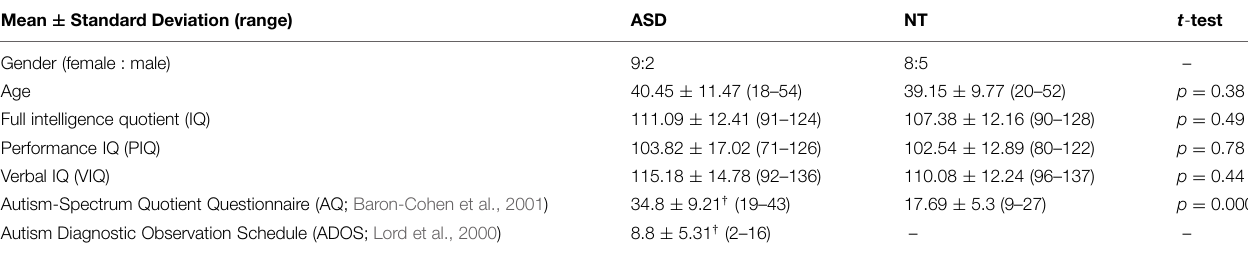
TABLE 1 | Mean-group matching data for the autism spectrum disorder (ASD) and neurotypical (NT) participants. Mean ± Standard Deviation